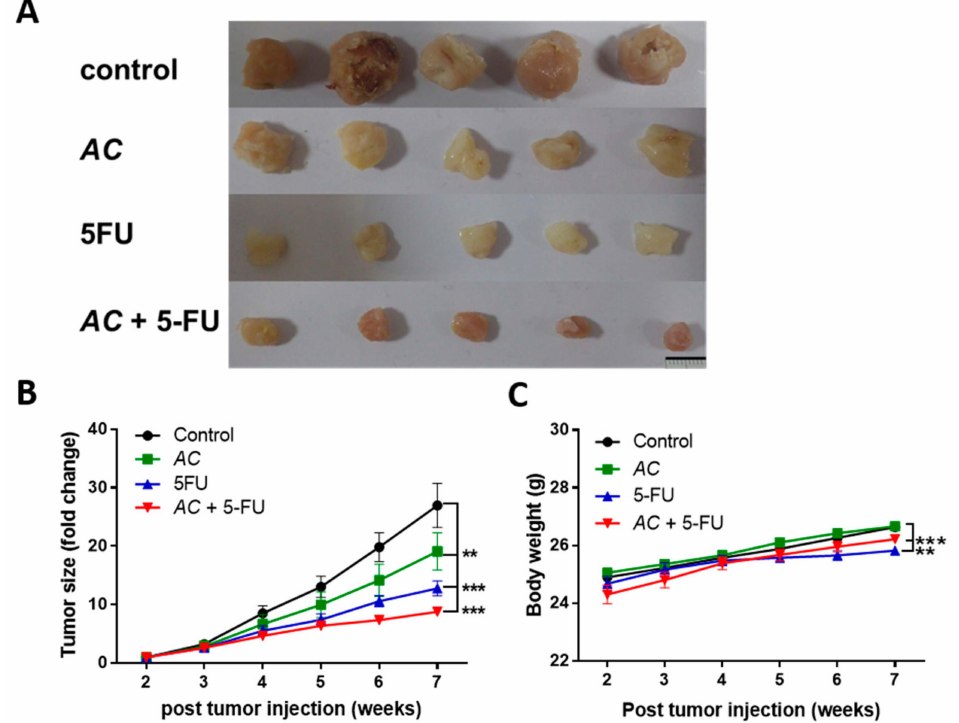
Figure 5. In-vivo tumor inhibitory e ff ect of AC . ( A ) Photographs of human colon cancer cells, DLD-1 (1 × 10 6 cells / injection, subcutaneous) were injected into NDO / SCD mice for establishing tumor xenograft model. When tumor size became palpable, mice were separated into four groups: Vehicle control, AC (50 mg / Kg), 5-FU (10 mg / kg), and combination AC + 5-FU (30 mg / kg 5-FU + 10 mg / kg AC ). ( B ) Evaluation of tumor suppressive e ff ect, synergistic e ff ect of AC + 5-FU significantly